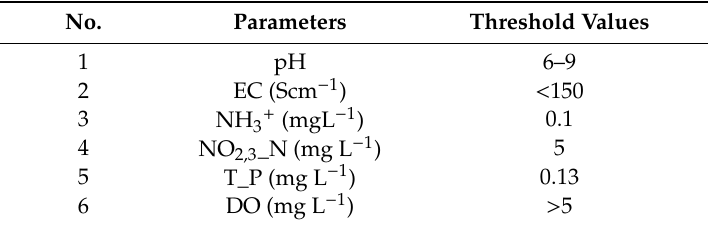
Table 1. Water quality parameters used for calculating the rating score of the water quality index for the protection of aquatic life. No. Parameters Threshold Values 1 pH